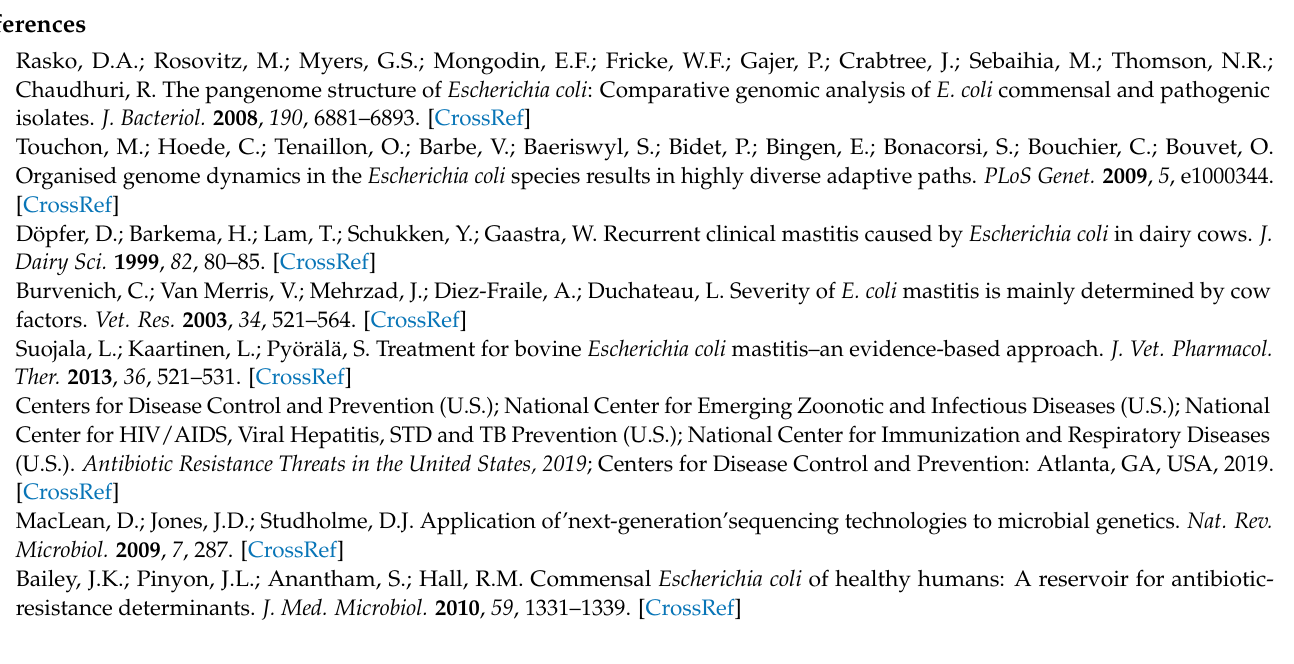
Table S2: Summary results of genes detected queried by ABRicate, Table S3: Closed related plasmid identified and queried by PLSDB with default